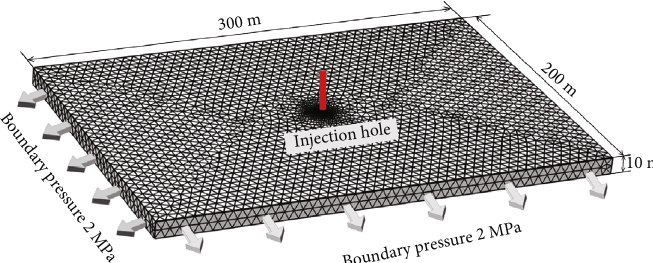
Figure 2: The 3D computational model.